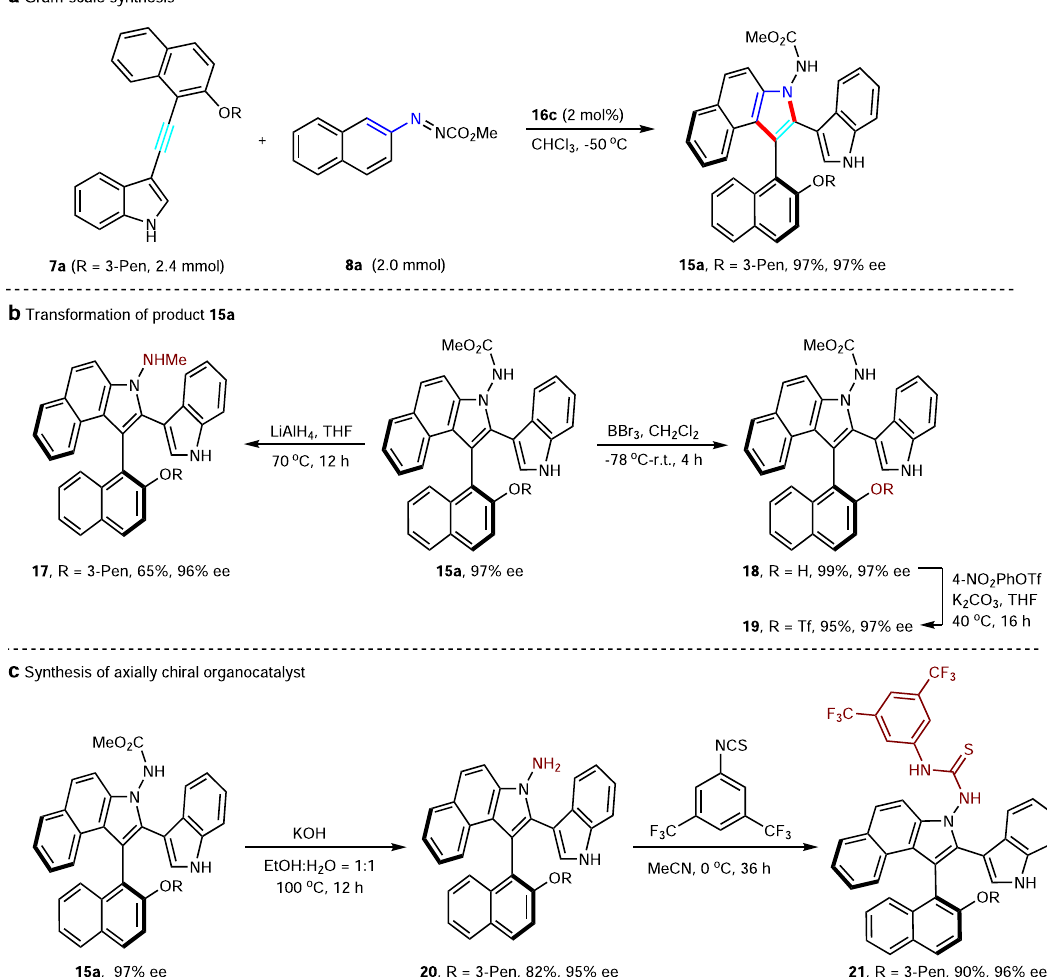
Fig. 4 Gram-scale synthesis and transformations. a Gram-scale synthesis of axially chiral compound 15a . b Transformation of compound 15a . c Synthesis of axially chiral